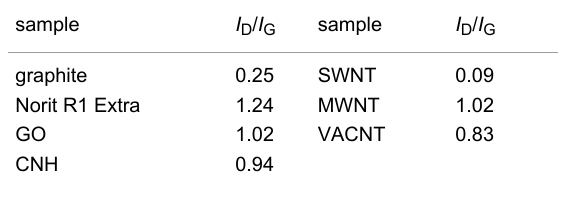
Table 1: The intensity ratios of D-band to G-band calculated from the Raman spectra of the different adsorbents.